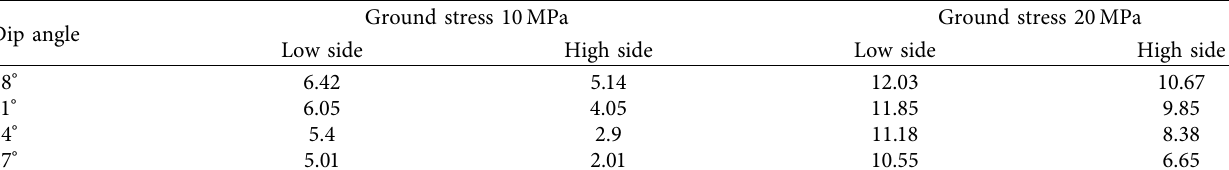
Table 2: Distance from peak stress concentration to both sides of roadway (mm). Dip angle